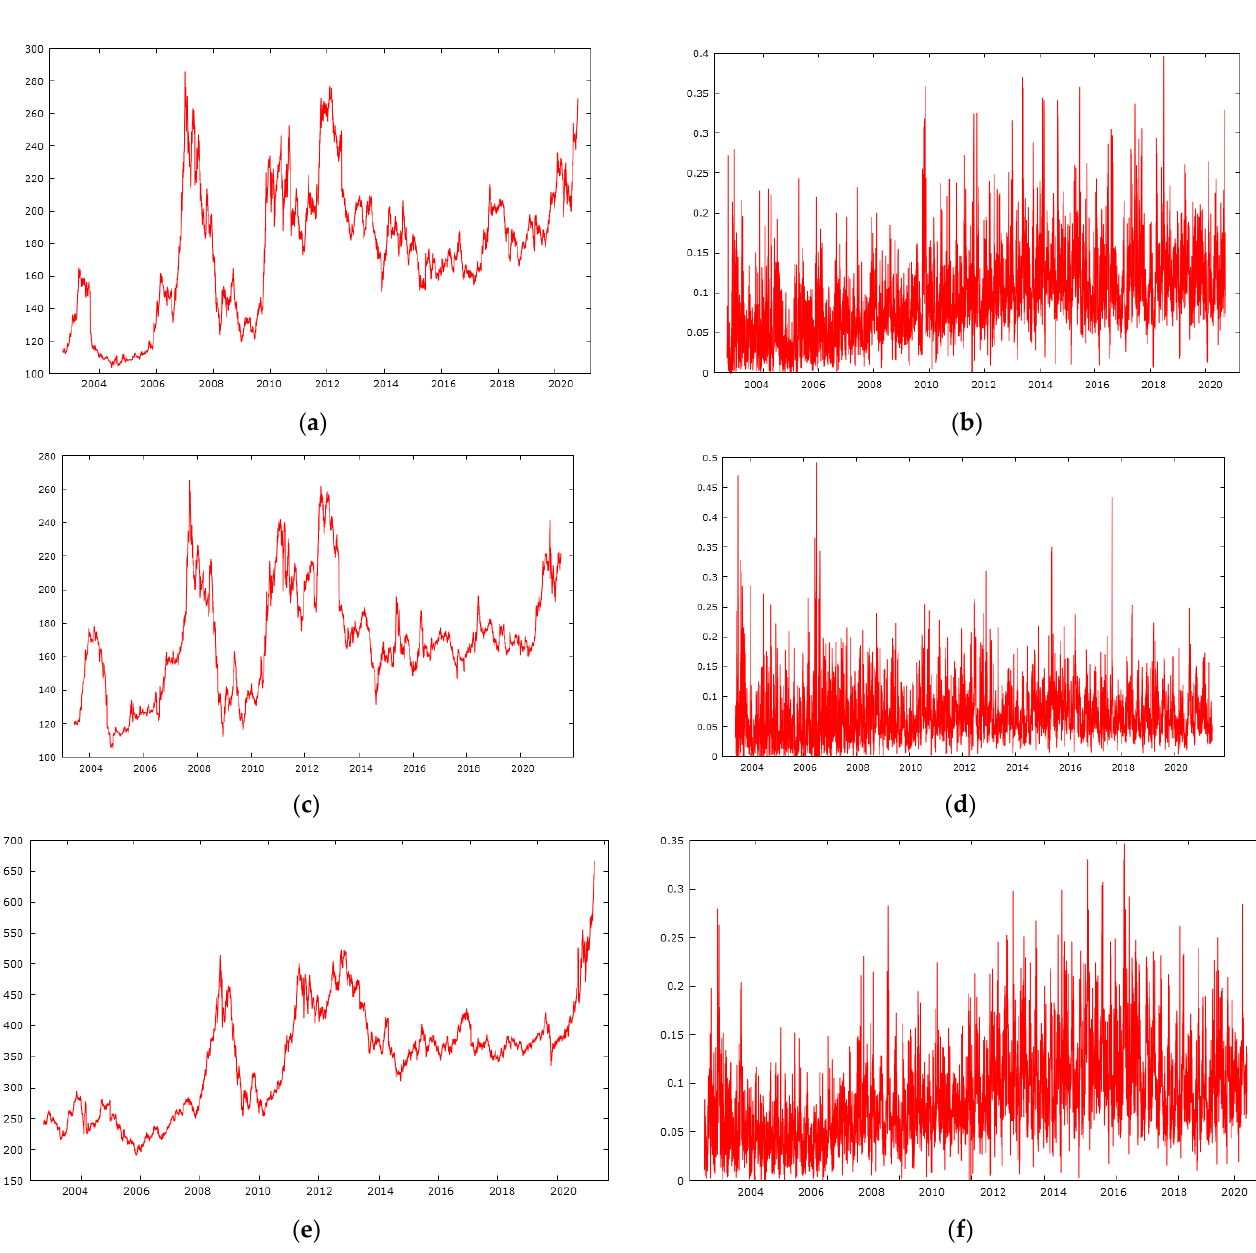
Figure A1. Price and short-term speculation index for selected commodity futures (April 2003–September 2021): ( a ) Price of milling wheat in Euros per metric ton; ( b ) Short-term speculation in the milling wheat market; ( c ) Price of corn in Euros per metric ton; ( d ) Short-term speculation in the corn market; ( e ) Price of rapeseed in Euros per metric ton; ( f ) Short-term speculation in the rapeseed market. Source: author’s calculations based on Euronext Commodities (MATIF) data, 2021.